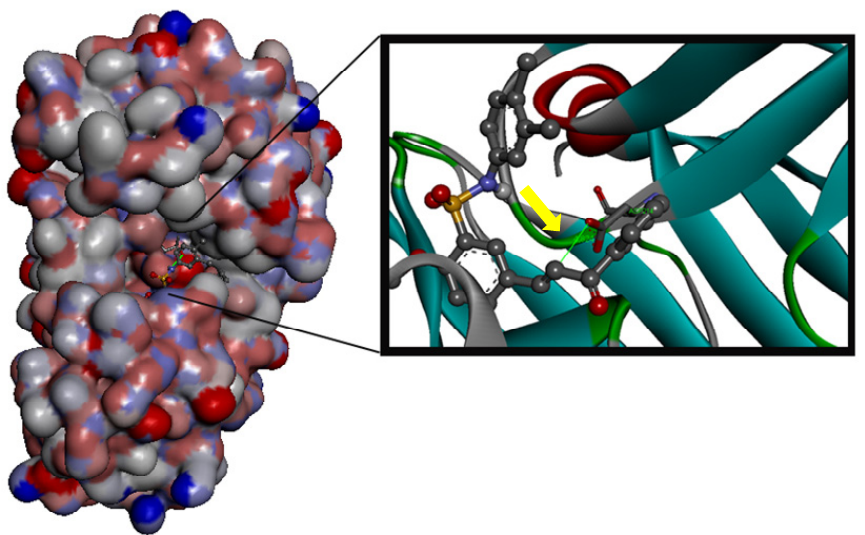
Figure 6. Compound 1f docked into the plasmepsin-2 (PL-2) binding site, generated by AutoDock Vina and viewed by Discovery Studio Client (version 3.1.1.11157). The α , β -unsaturated ketone system of chalcones acts as a Michael acceptor with